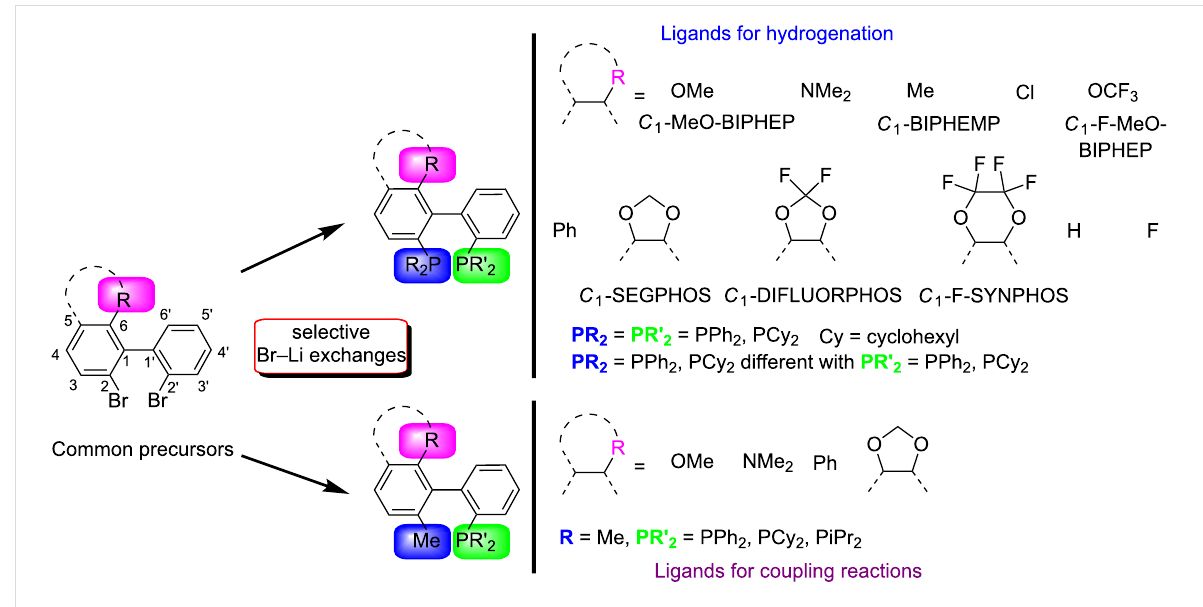
Figure 1: Modular synthesis of bis(diarylphosphino)-, bis(dialkylphosphino)- and dialkyl(diaryl)phosphinobiphenyls as well as monophosphino- biphenyls by means of polar organometallic